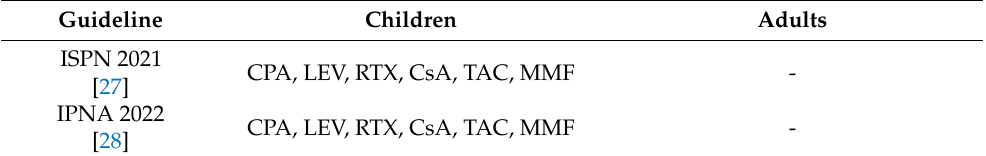
Abbreviations: KDIGO, Kidney Disease Improving Global Outcomes; JSPN, Japanese Society for Pediatric Nephrology; JSN, Japanese Society of Nephrology; GSPN, German Society for Pediatric Nephrology; ISPN, Indian Society of Pediatric Nephrology; IPNA, International Pediatric Nephrology Association; CPA, cyclophosphamide; CLB, chlorambucil; LEV, levamisole; RTX, rituximab; CsA, cyclosporine; TAC, tacrolimus; MMF,